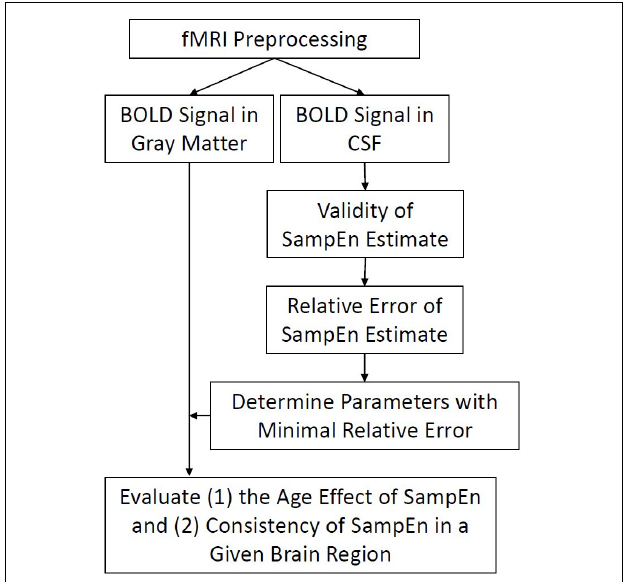
FIGURE 1 | Flow chart of analyses. Functional imaging data were preprocessed and BOLD signal in every gray matter and CSF voxels was extracted for subsequent SampEn/MSE analysis. The evaluation of SampEn of BOLD signal is twofold. First, we evaluated the validity of SampEn calculation using a variety of combinations of parameters m , r , and Scale Factors. Second, we evaluated the relative error of BOLD signal using a minimization strategy. Finally, we applied the obtained parameters to study the effect of age in SampEn of gray matter voxels and evaluated the consistency of SampEn in a given brain